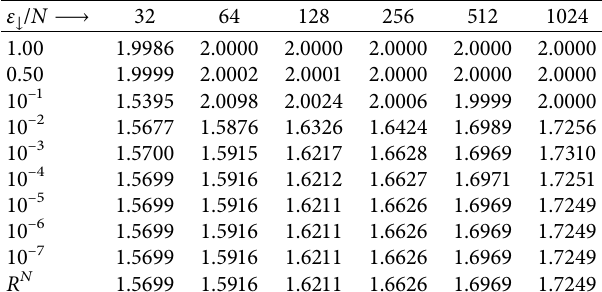
Table 4: Result of Example 2 (rate of convergence) for δ � η � 0.5 ∗ ε